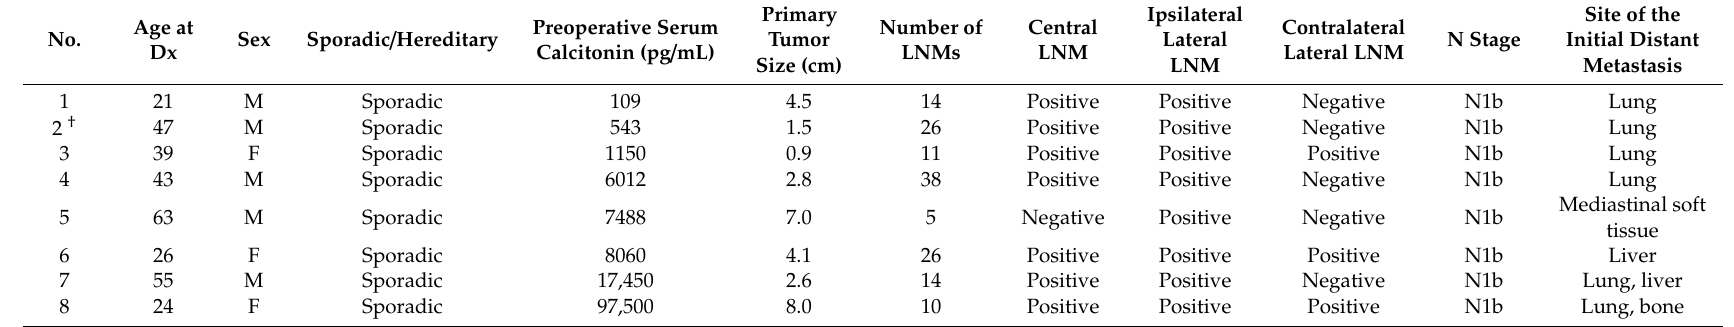
Table 5. Detailed information of patients with distant